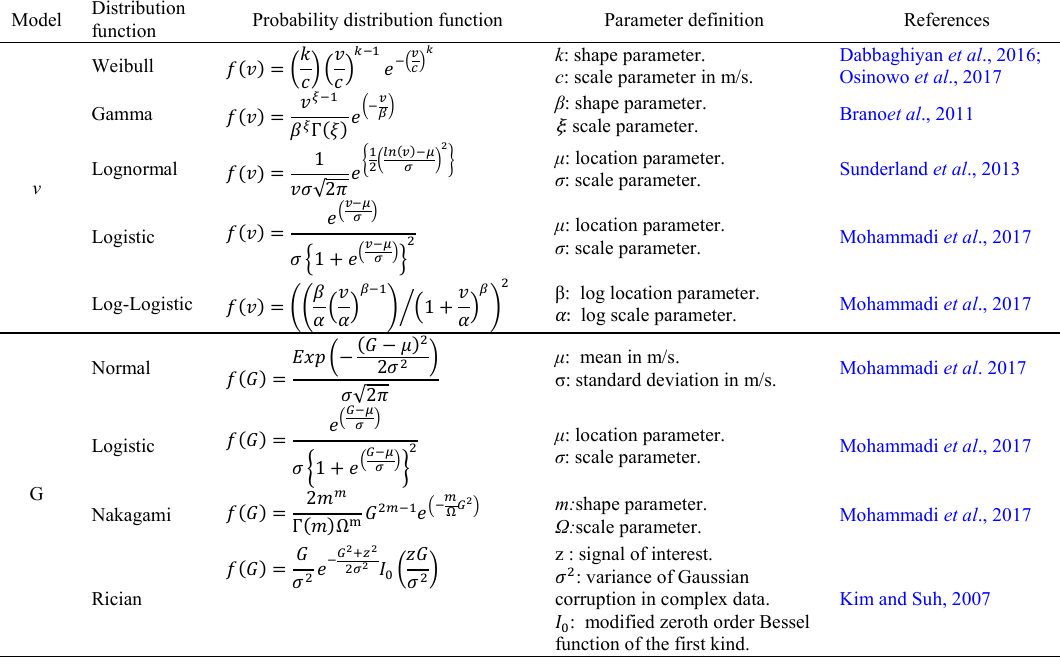
Table 1: Expressions of statistical distributions used in this study Model